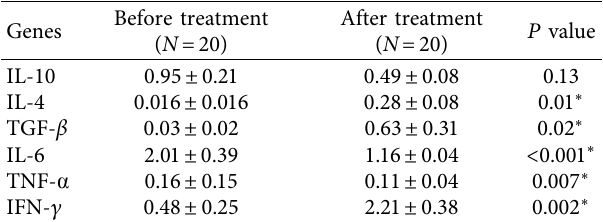
Table 2: Comparison of relative cytokines genes expression before and after treatment with vitamin